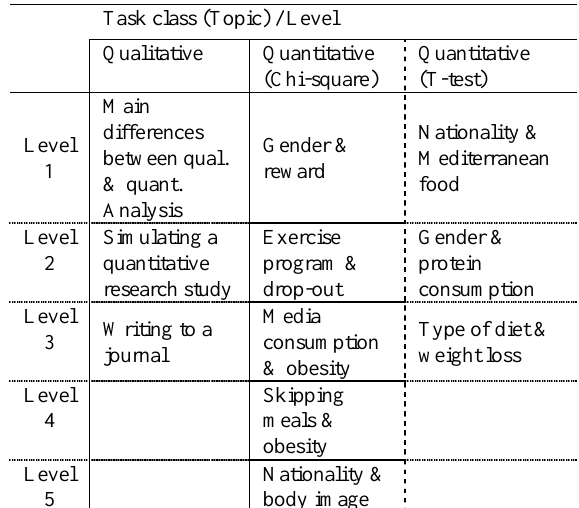
Table 1. The CHERMUG mini-games divided by their task classes and